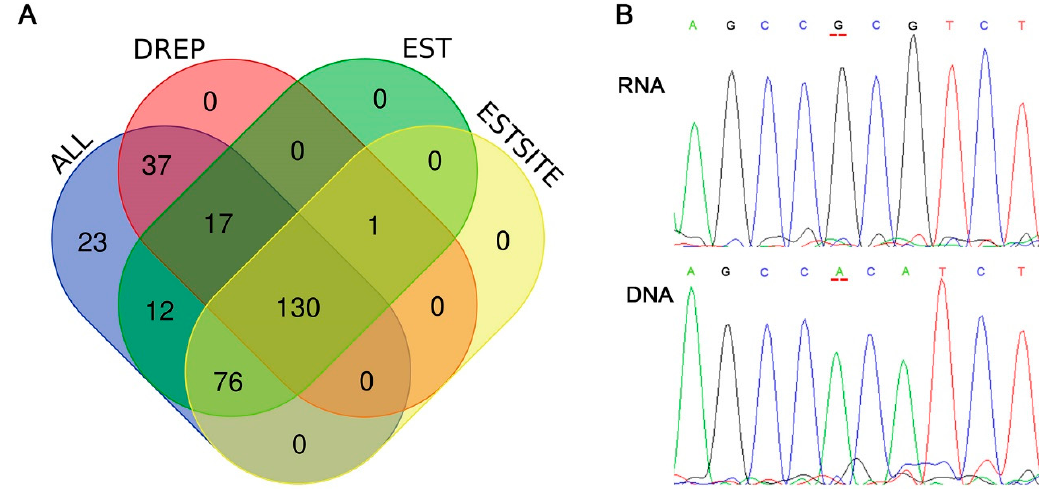
Figure 4. Validation of RNA editing sites. ( A ) Venn diagram of the RNA editing sites searching in other databases. EST, Expression site tags; DREP, Database of RNA Editing in Pig; ALL, all of the 295 editing sites detected in this research; ESTSITE, EST clones with known editing sites. ( B ) Sanger sequencing plot showing different nucleotide (A and G) between genomic DNA and RNA at same position (editing site at Sus scrofa chromosome 13: 111023145-). The sites are highlighted in red lines.